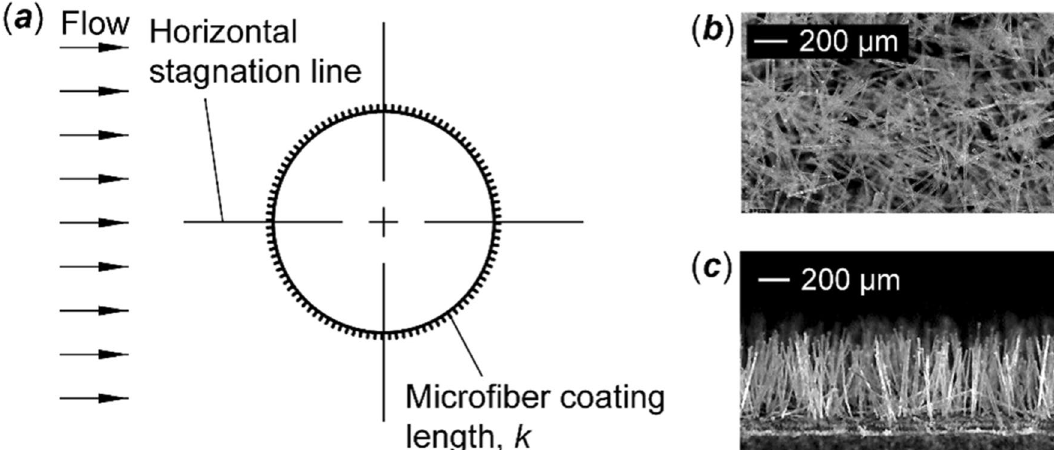
Figure 1. A schematic of the fully microfiber-coated cylinder. ( a ) Coating configuration on the cylinder model. The fiber length k was 0.5 mm, which was 1% of the cylinder diameter. ( b ) A microscope image of fabricated microfiber coating seen from top. ( c ) A microscope image of fabricated microfiber coating seen from